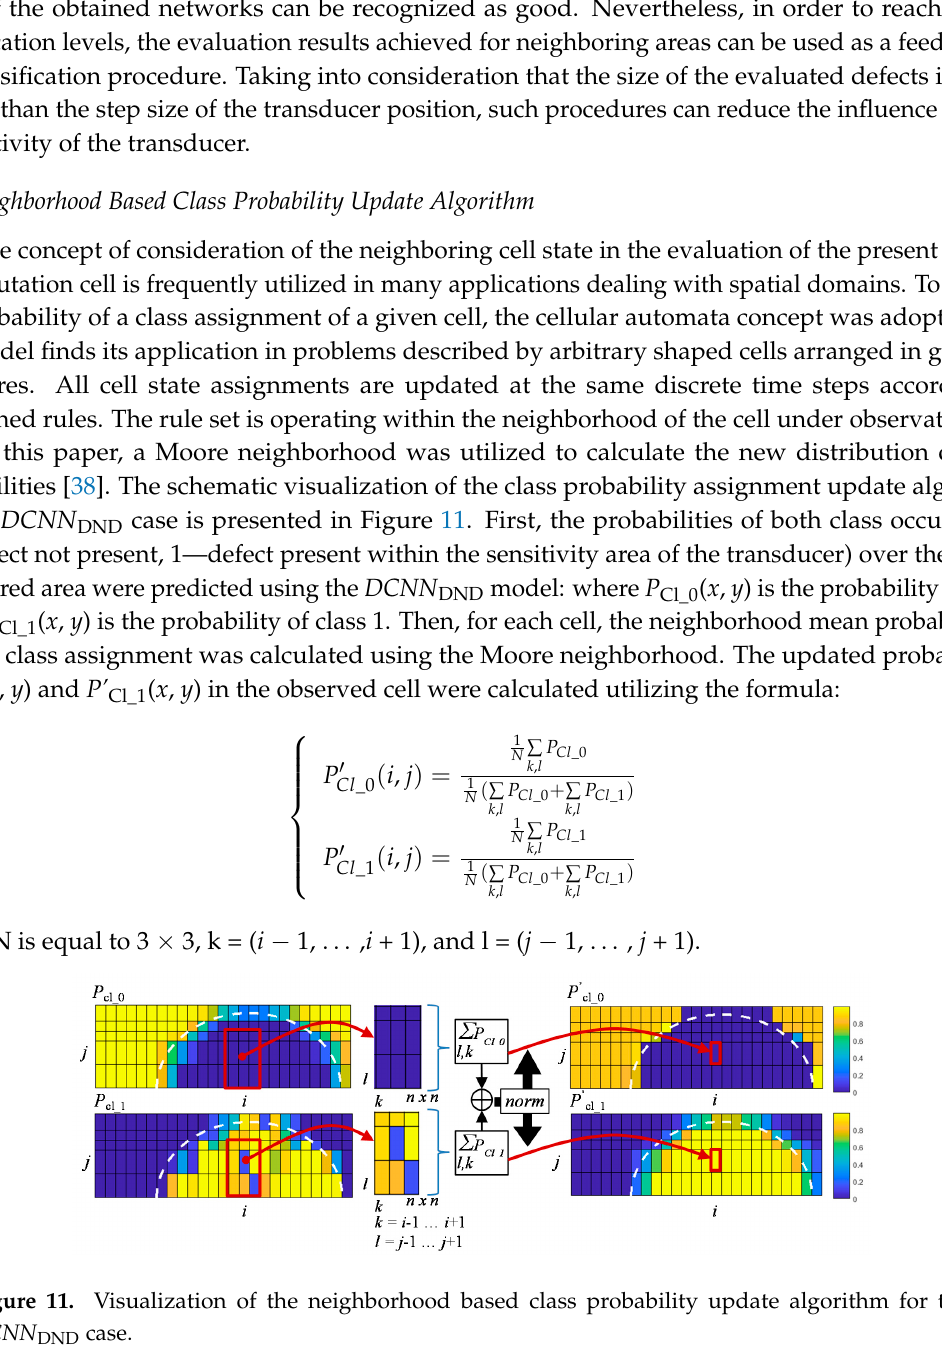
94.01 Table 6. Confusion matrix of the DCNN ROT after evaluation update procedure [%]. Defect r 0 100 Table 7. Confusion matrix of the DCNN DEP after evaluation update procedure [%]. Defect d 0.5